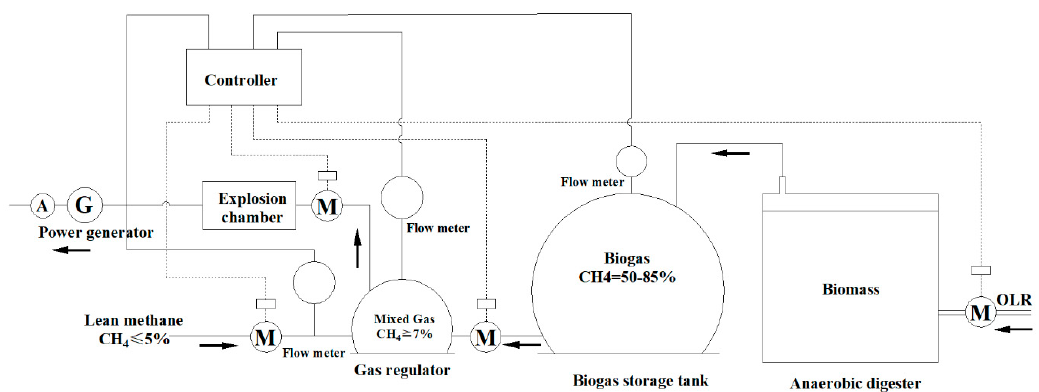
Figure 5. Control system of the lean methane and biogas co-production in coal mines.